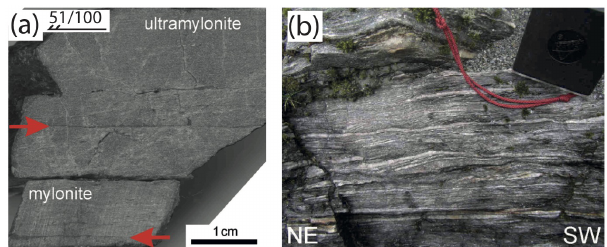
Figure 2. (a) Quartzofeldspathic Alpine Fault ultramylonite that gradually grades to mylonite at the base of the image from Gaunt Creek (43 ◦ 19 (cid:48) 00.62 (cid:48)(cid:48) S, 170 ◦ 19 (cid:48) 32.79 (cid:48)(cid:48) E). A foliation de- fined by alternating white quartzofeldspathic bands and dark grey mica bands is hard to distinguish in the ultramylonite but is more apparent in the mylonite. (b) The well-foliated Alpine Fault protomylonite–mylonite transition at Gaunt Creek (43 ◦ 19 (cid:48) 05.11 (cid:48)(cid:48) S, 170 ◦ 19 (cid:48) 46.16 (cid:48)(cid:48) E). Compass is 5cm wide. Both images were previ- ously presented in Toy